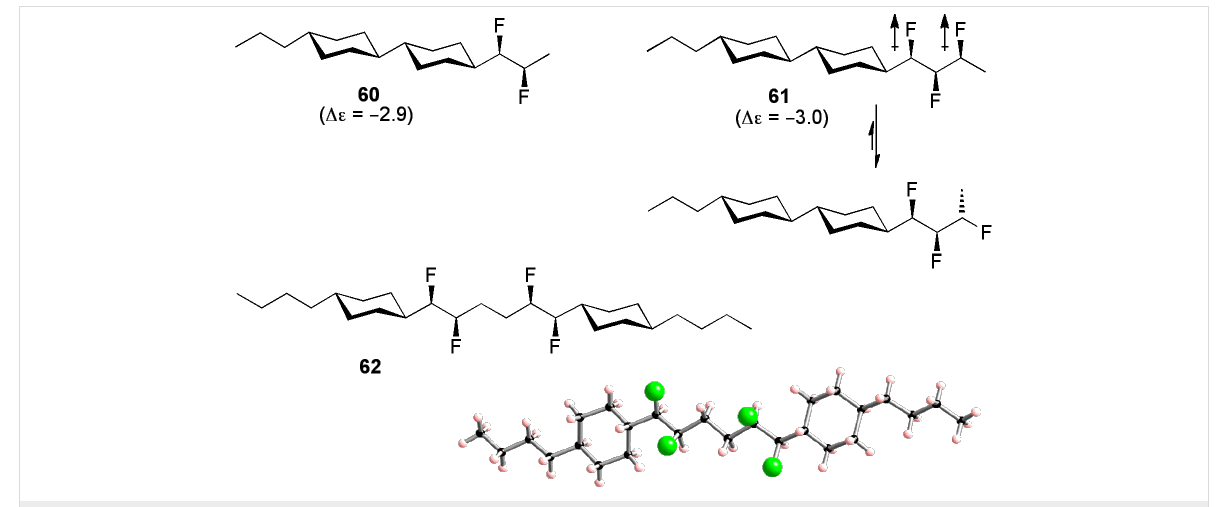
Figure 15: Di-, tri- and tetra-fluoro liquid crystal molecules 60 – 62 .